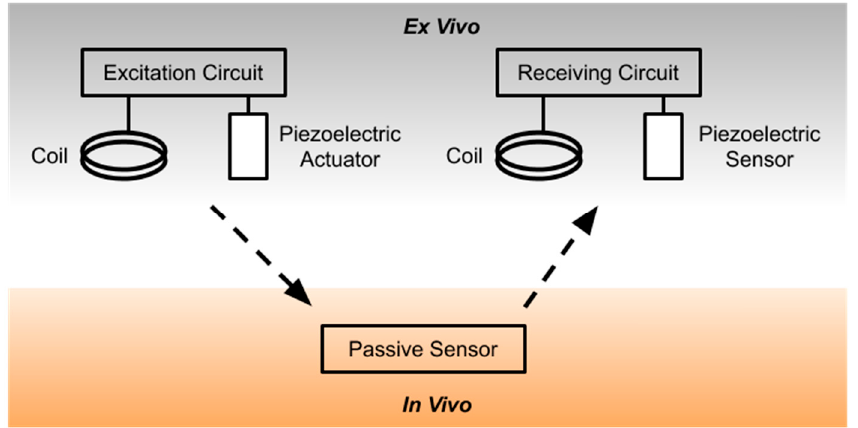
Figure 2. The design of a generic passive interrogator. A signal is generated in the excitation circuit and transmitted at radiofrequency (RF) using an inductive coil or at ultrasound frequencies using a piezoelectric element. The reflected signal is received by a receiving circuit using a matching coil or piezoelectric element.